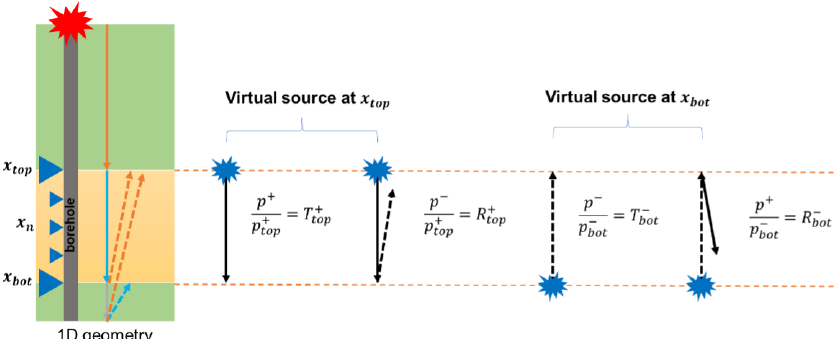
Figure 2. Illustration of the reflection and transmission response by deconvolution interferometry with an active source at the surface (red explosion) and virtual source at the top and bottom geophone (blue explosions). The solid and dashed lines indicate the down- and upgoing waves. Orange and light blue lines portray wave paths that are recorded at x top and x bot (both up- and downgoing wave).